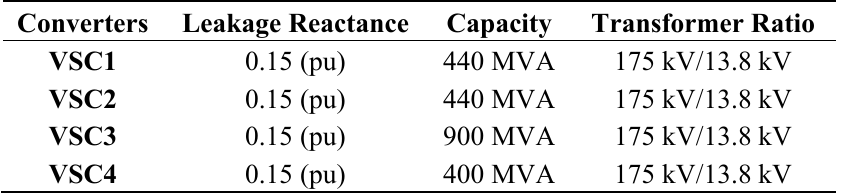
Table 2. Parameters of Commutating